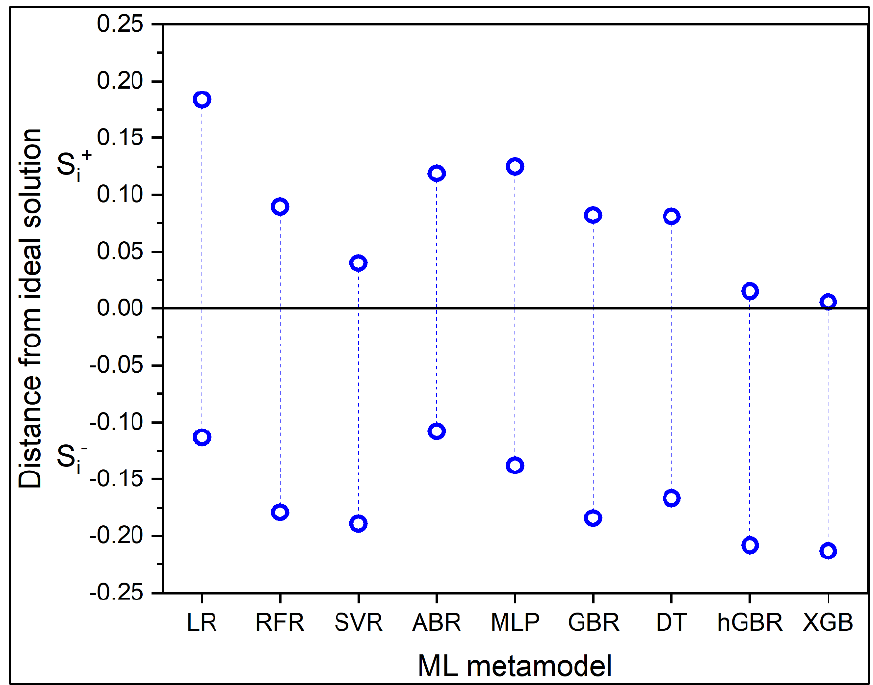
Figure 9. Distance of each alternative (ML metamodel) from the hypothetical ideal solution.